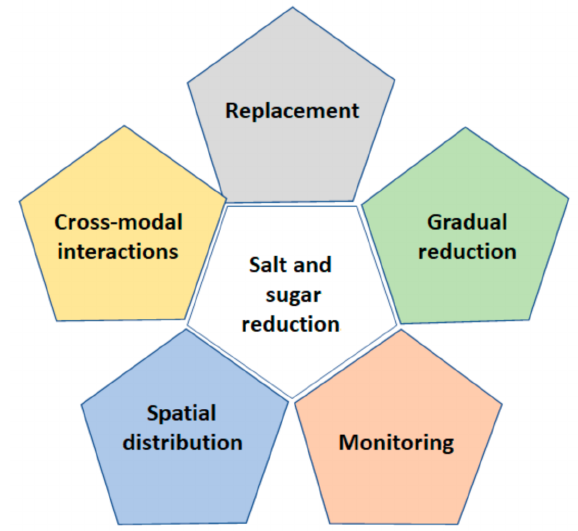
Figure 1. Strategies for salt and sugar reduction in